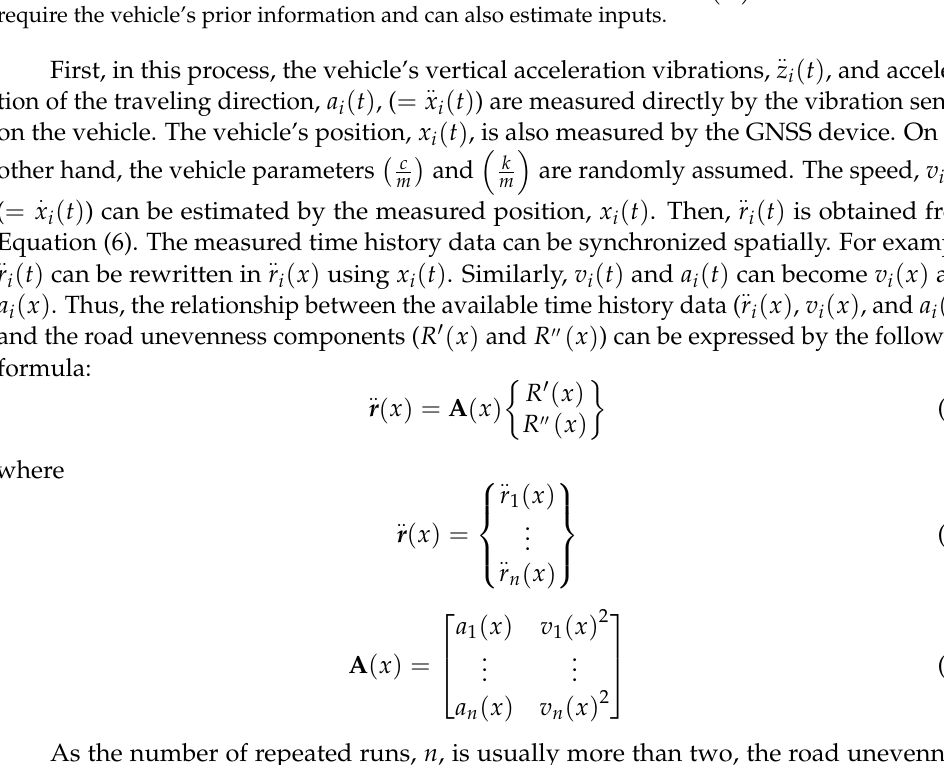
(cid:16) (cid:17) (cid:0) c (cid:1) (cid:4673) and (cid:4672) (cid:3038) (cid:4673) . This process does not k and . This process does not (cid:3040) (cid:3040) m m